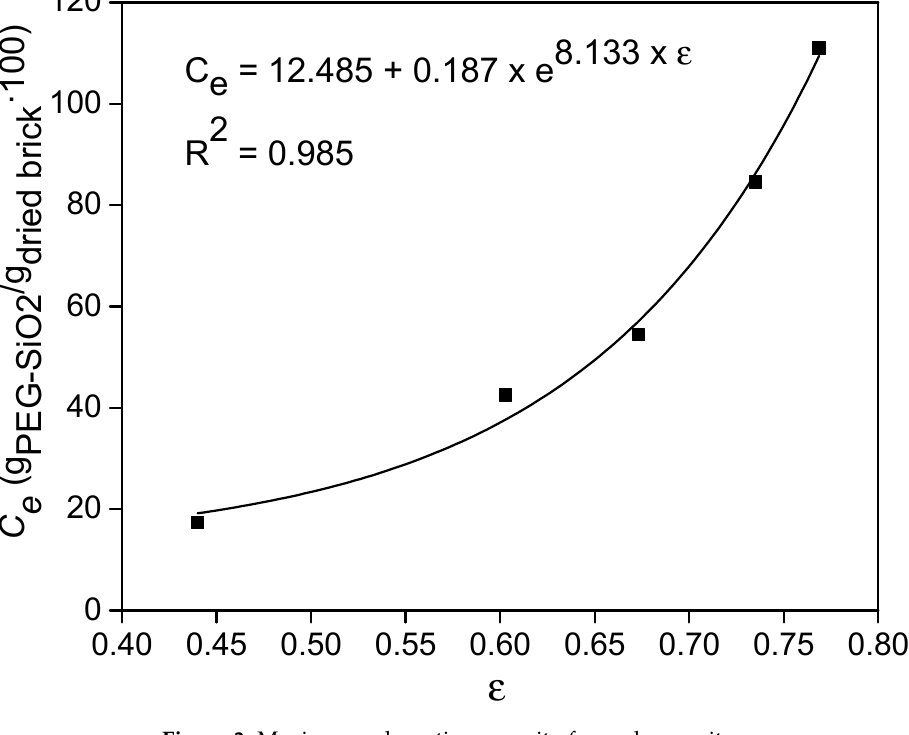
Figure 3. Maximum adsorption capacity for each porosity.